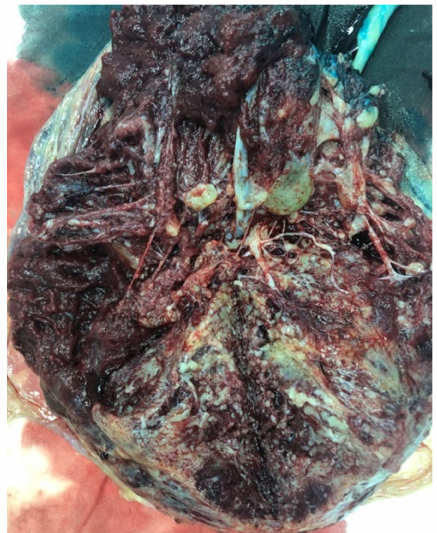
Figure 5. Placentomegaly with dilated vessels on the chorionic